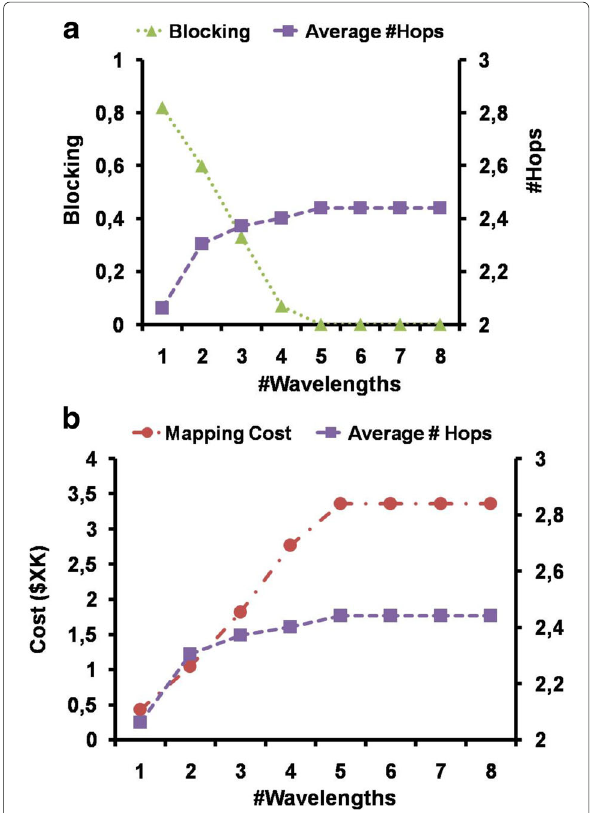
Fig. 8 Impact of number of wavelengths per fiber. a Blocking and number of hops. b Mapping cost and Number of hops